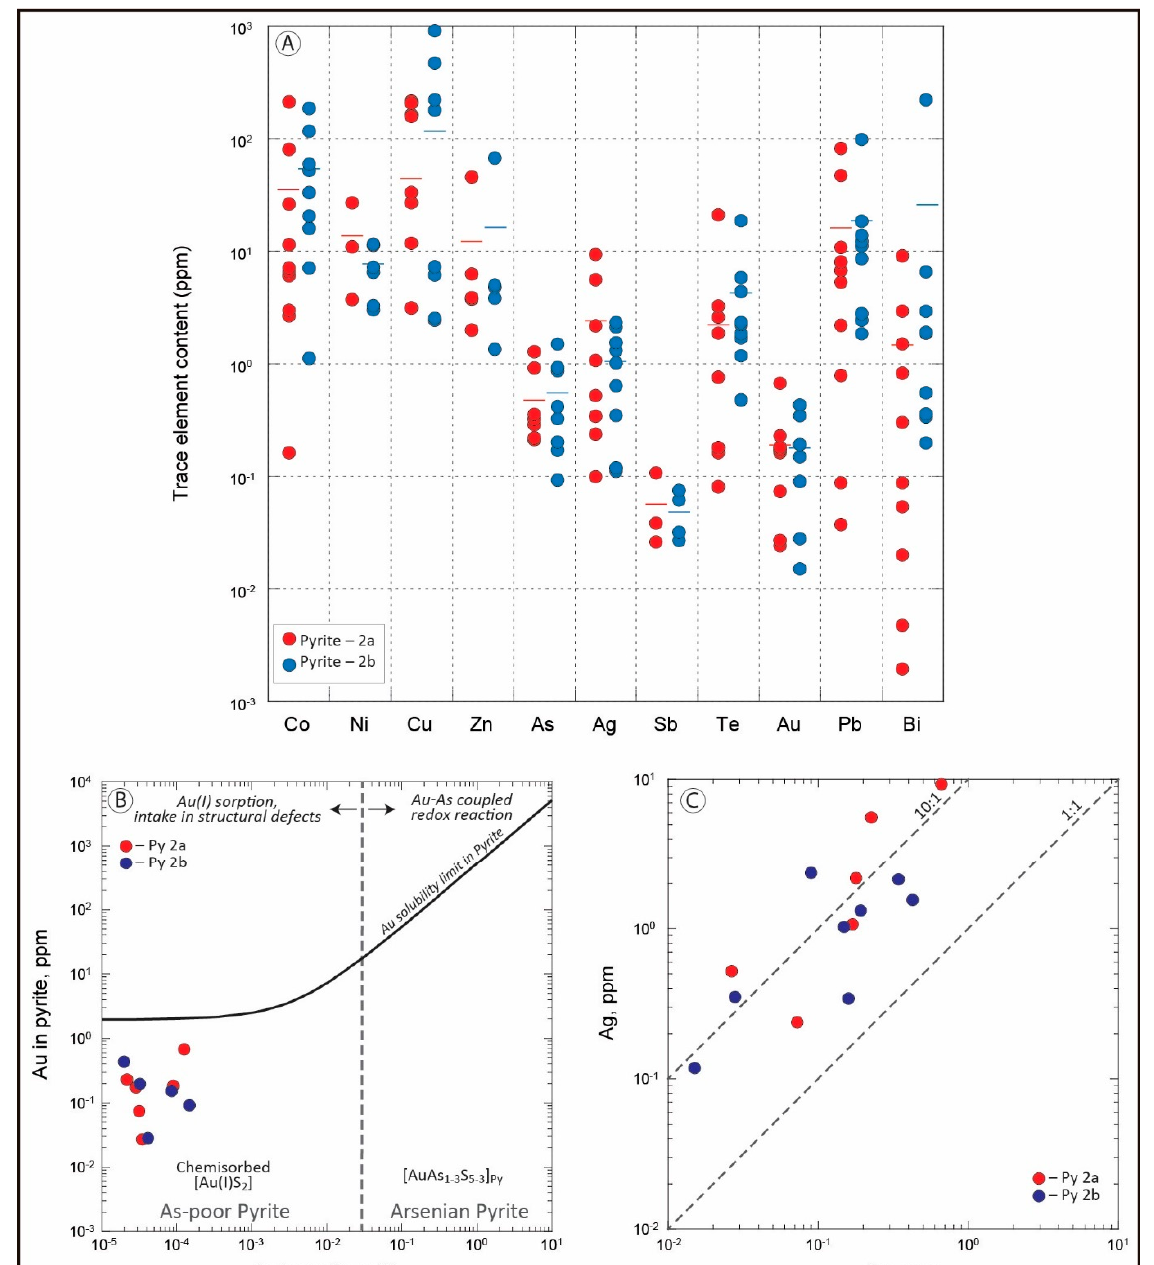
Figure 5. Trace element distribution in pyrite generations 2a and 2b (full dataset available in Supplementary Material C: Table S1): ( A ) Trace element content by pyrite generation (in ppm). Horizontal bars correspond to average values; ( B ) As vs. Au content in pyrite (modified from [50]; gold solubility limit in pyrite from [51]; ( C ) Au vs. Ag content in pyrite.